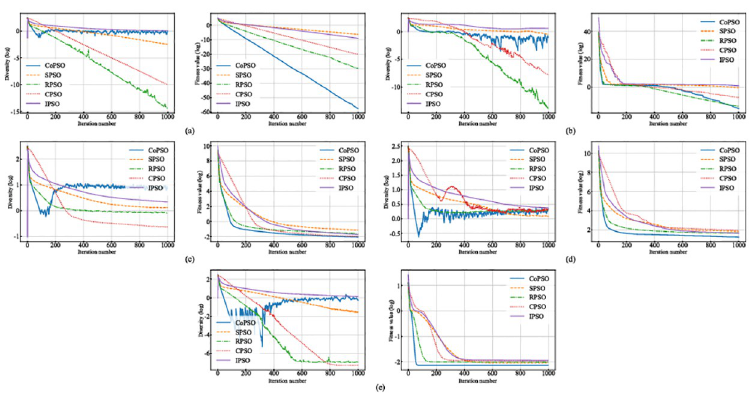
Fig 4. Average swarm diversities and average global best fitness values of all algorithms at each iteration. Note that the vertical axes are in logarithmic form. (a) The results on f 1 . (b) The results on f 2 . (c) The results on f 3 . (d) The results on f 4 . (e) The results on f 5 .